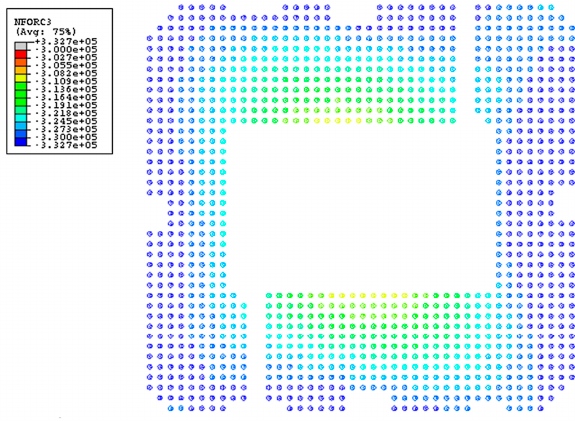
Figure 9. Example of temperature - humidity (TH) open failure.